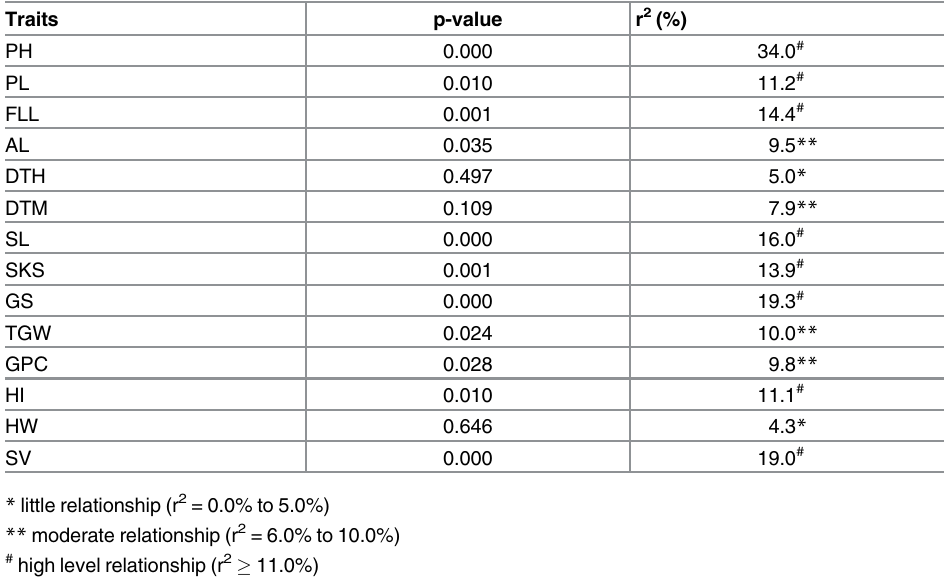
Fig 1. Frequency distribution of morphological, yield related and quality traits used for association mapping. doi:10.1371/journal.pone.0159343.g001 Table 1. Relationships between the phenotypic traits and population structure computed using the mean values across environments. Probability (p-value) and r 2 values (%) for phenotype – population struc- ture relationship are based on the multiple regression